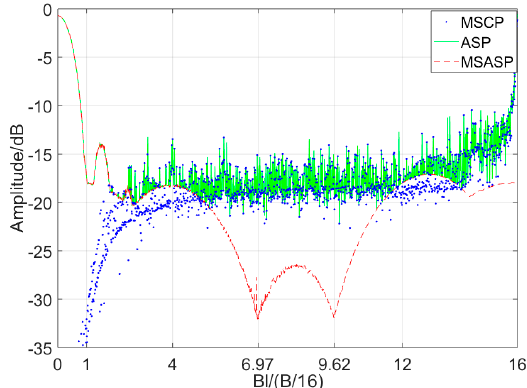
Figure 4. Autocorrelation sidelobe peak (ASP), multiple sub-cross-correlation peak (MSCP), and multiple sub-autocorrelation sidelobe peak (MSASP) curve of conventional OFDM chirp with B l n / B / /16 l B B . n